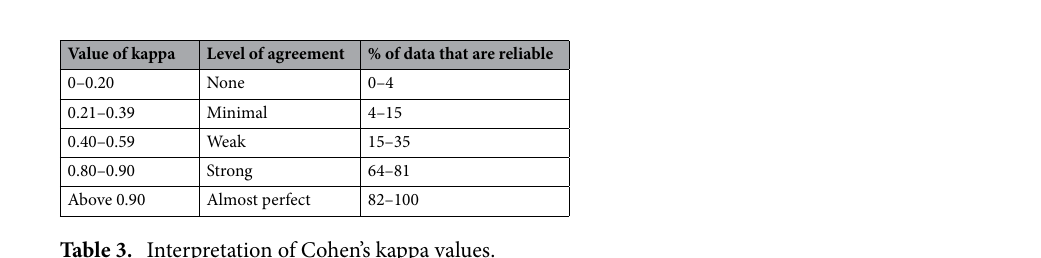
Table 3. Interpretation of Cohen’s kappa values.